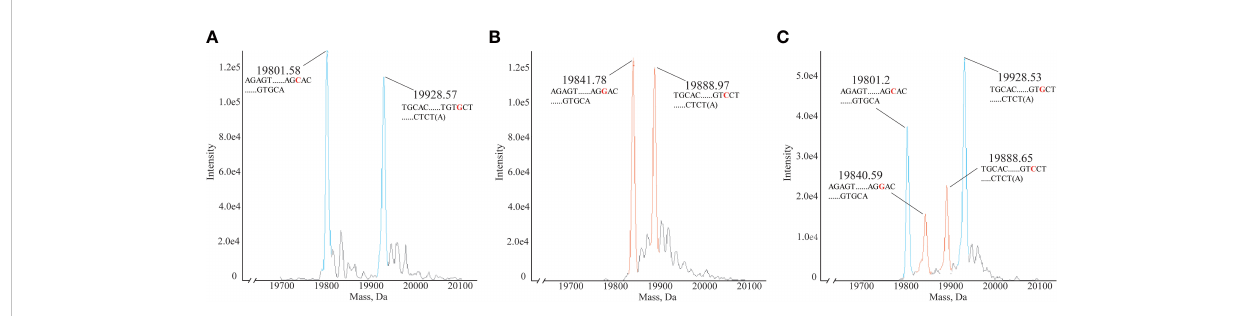
FIGURE 5 Mass spectra of homozygous and heterozygous samples. (A) Mass spectrum of homozygous Sample 4 No. 12. HLAMSTT, typing: HLA- DQA1*03:01:01, molecular weights: 19801.58 Da and 19928.57 Da. (B) Mass spectrum of homozygous Sample 10 No. 12. HLAMSTT typing: HLA- DQA1*02:01:01, molecular weights: 19841.78 Da and 19888.97 Da. (C) Mass spectrum of heterozygous Sample 16 No. 12. HLAMSTT typing: HLA- DQA1*03:03:01 and HLA-DQA1*05:05:01, molecular weights: 19801.2 Da, 19840.59 Da, 19888.65 Da, and 19928.53